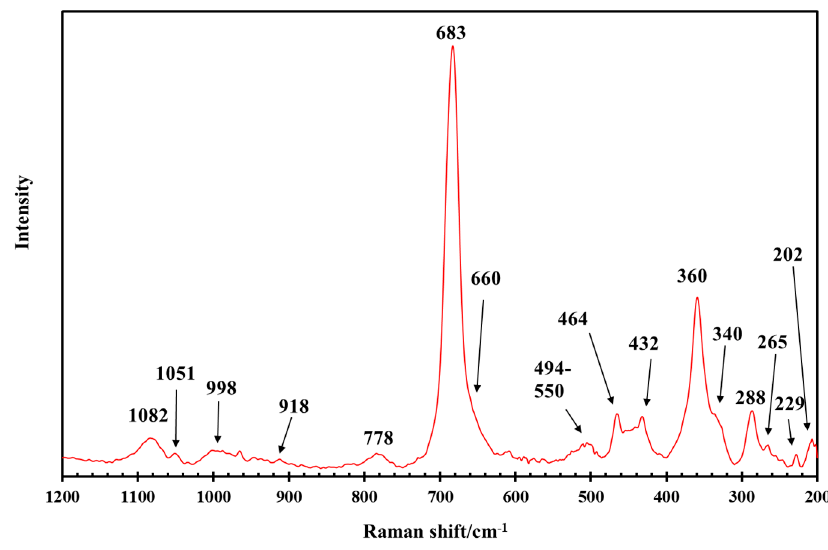
Figure 4. Raman spectrum of natural saponite (Milford) in the region between 1200 and 200 cm − 1 . Table 1. Raman and mid-IR band positions and suggested assignments for Milford and synthetic NH 4 -saponite. Raman